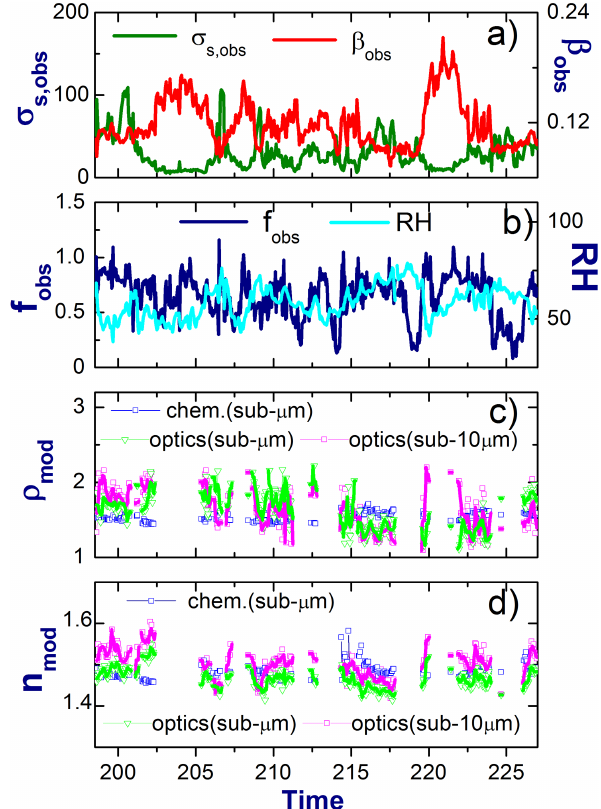
Figure 6. Time series of (a) light-scattering coefficient ( σ s , obs ) and hemispheric backscattering fraction ( β obs ) measured for sub-10- micron ( D p <10µm) particles by integrating nephelometer, (b) rel- ative humidity (RH) and the fine-mode fraction of light scatter- ing ( f obs ) , (c) the effective density calculated from the sub-micron ( D p <1µm) dry chemical composition ( ρ mod , chem ; blue squares) and the retrieved ( ρ mod , opt ) from optical properties measured for sub-micron (green triangles) and sub-10-micron (magenta squares) particles, and (d) the real refractive index calculated from the sub- micron dry chemical composition ( n mod , chem ; blue squares) and re- trieved ( n mod , opt ) from optical properties measured for sub-micron (green triangles) and sub-10-micron (magenta squares) particles. (c, d) Solid lines (blue, green and magenta) represent the smoothed versions (boxcar averaging; 5 points) of the corresponding calcu- lated and retrieved aerosol characteristics (blue, green, and magenta squares). Appendix B includes “zoom-in” versions of Fig.